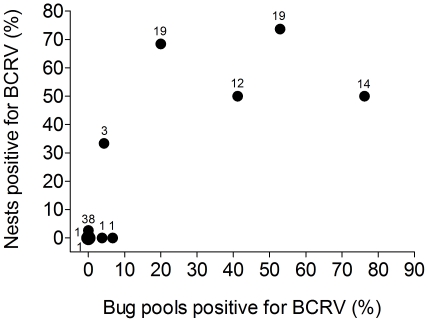
Percentage of house sparrow nests with ≥ 1 nestling positive for BCRV in relation to the percentage of BCRV-positive swallow bug pools in a colony (rs = 0.77, p = 0.009).Swallow bugs were collected at colonies containing both cliff swallows and house sparrows from the outsides of active cliff swallow nests. Sample sizes (number of nests) for each colony are shown near the symbols. The large circle represents two colonies with the same value.